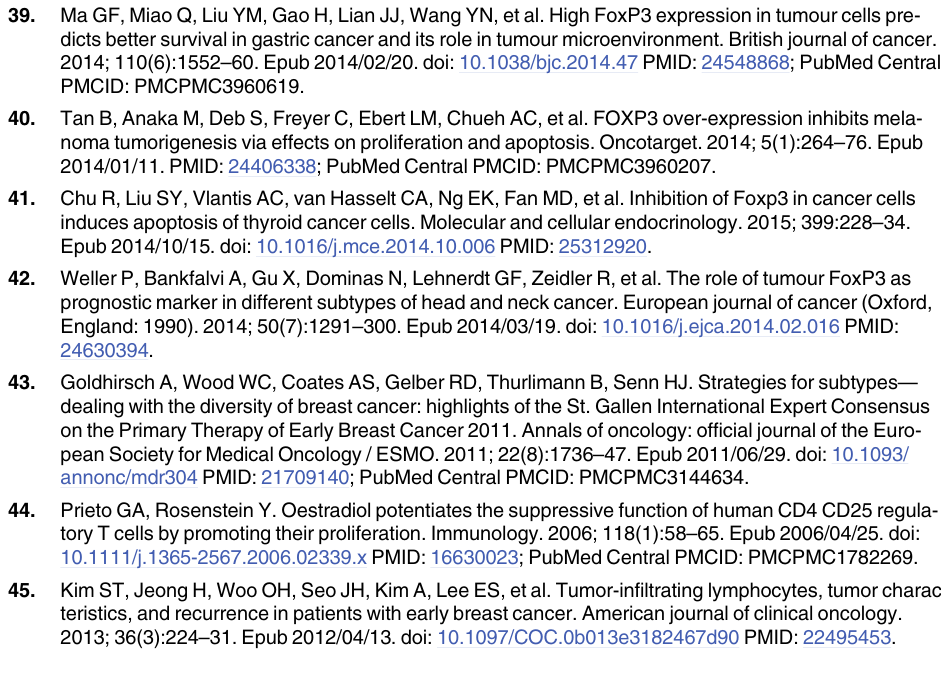
PLOS ONE | DOI:10.1371/journal.pone.0136374 August 25,